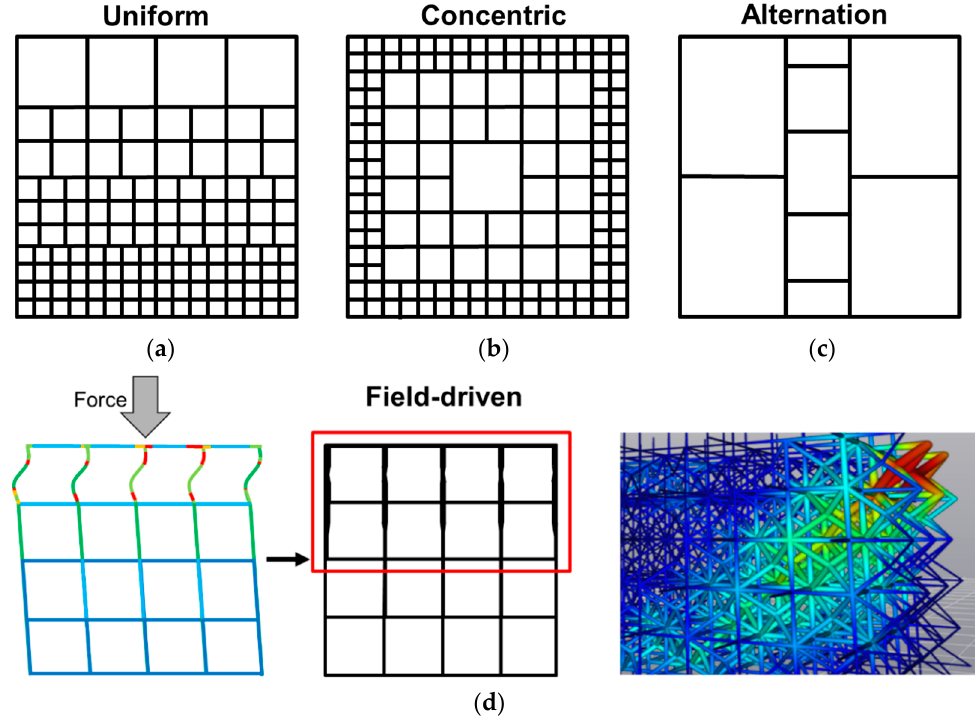
Figure 10. Different patterns that gradation can be applied with: ( a ) uniform, ( b ) concentric, ( c ) al- ternation, and ( d ) field-driven. ( a – c ) demonstrate the patterns for proportion gradation of the unit cell, while ( d ) demonstrates this for proportion gradation of the member (in this case, the beams thickness varied as a function of von-Mises stresses, represented by the color contours.